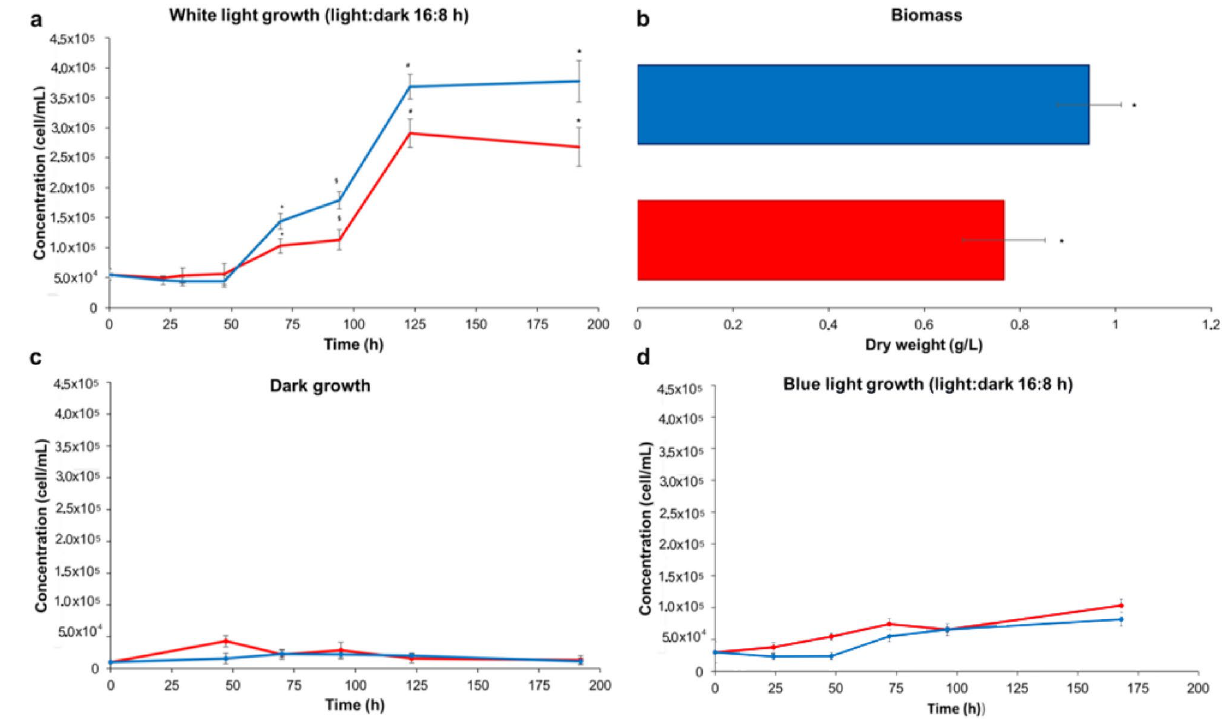
Figure 3. ( a ) Curves for diatom growth and ( b ) biomass recorded, under normal lighting conditions, in the presence (blue line) and absence (red line) of Cy5. Curves for diatom growth recorded under ( c ) darkness and ( d ) blue light